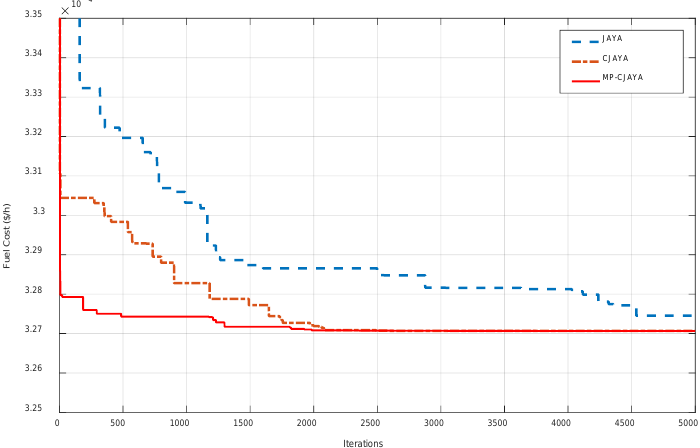
P = 2630 MW). Figure 11. Fuel cost convergence characteristic of 15-units system ( P D = 2630 P = 2630 MW). D D